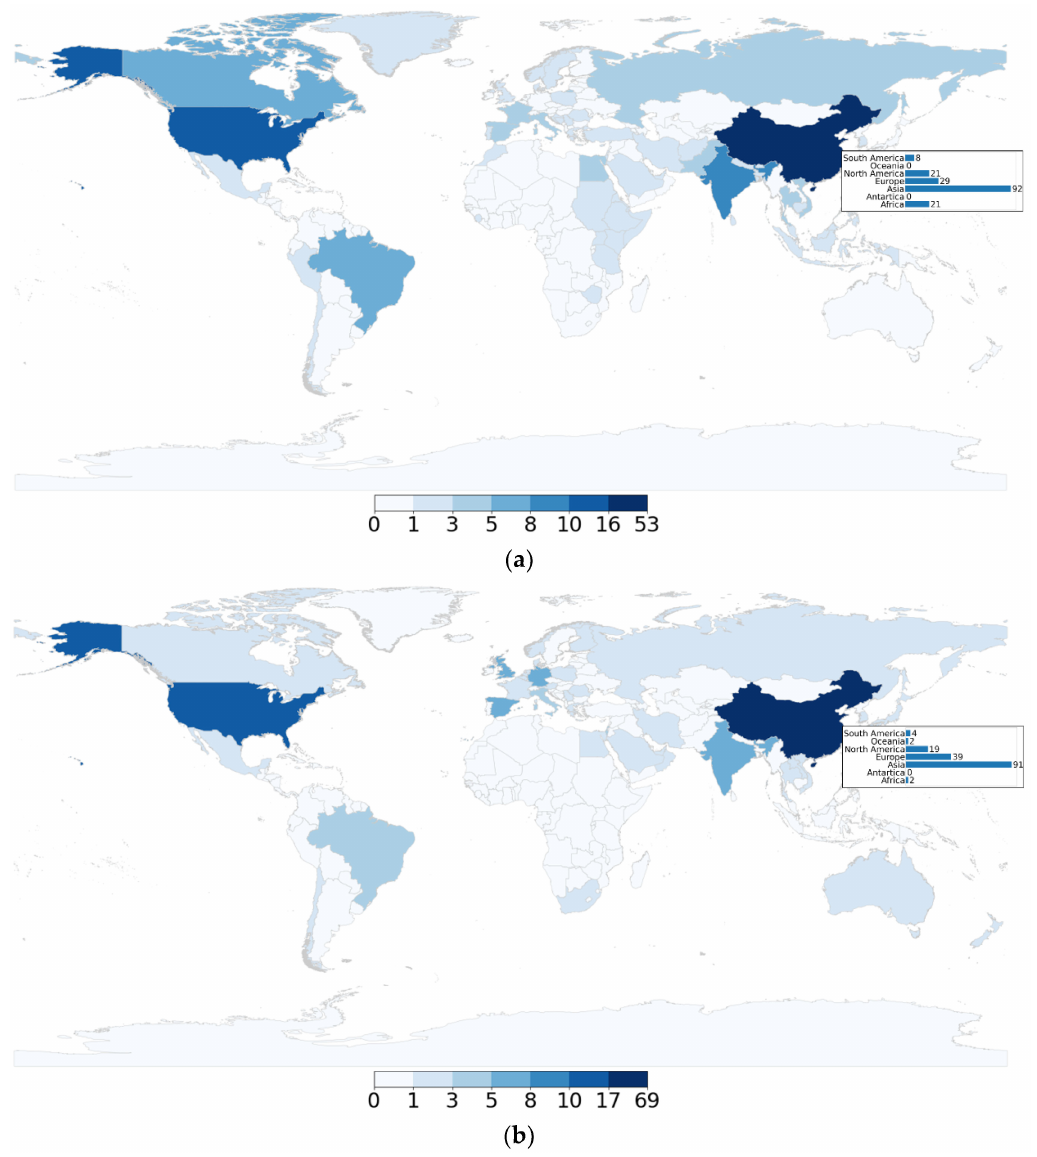
Figure 5. Maps of absolute number of studies per country ( a ) and first author affiliations per country ( b